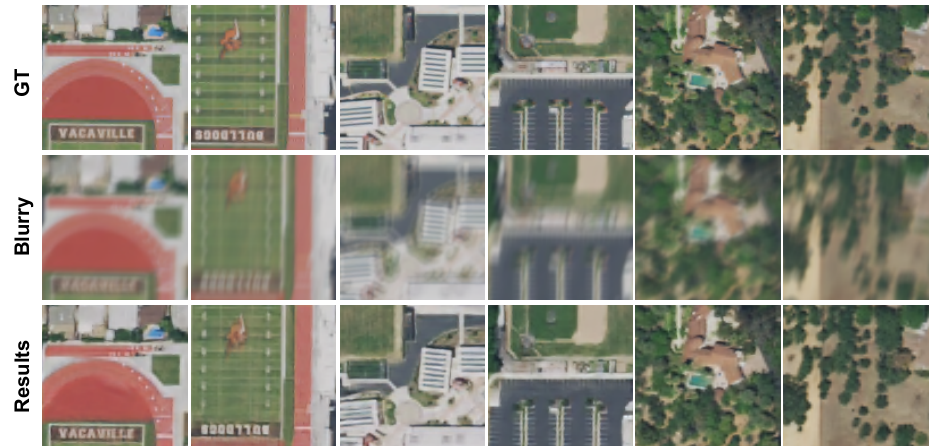
Figure 13. The images restored by Ref-MFFDN of size 128 × 128 pixels.